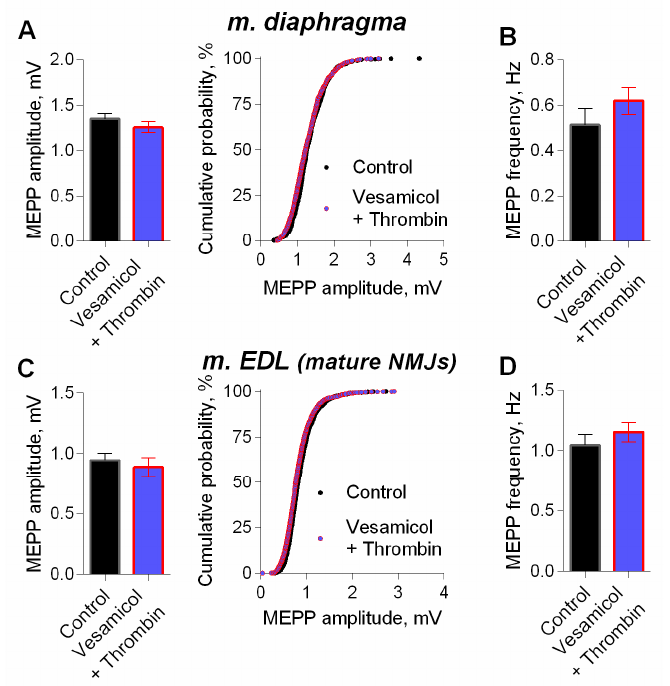
Figure 4. Inhibition of vesicular ACh transporter abolished thrombin-induced increase in MEPP amplitude. ( A ) Mean amplitude of MEPPs (left) and cumulative probability plots (right) in control ( n = 21) and upon application of thrombin (1 nM) in the presence of vesamicol (1 µ M) ( n = 24) at diaphragm NMJs. ( B ) Mean frequency of MEPPs in control and upon application of thrombin in the presence of vesamicol at diaphragm NMJs. ( C ) Mean amplitude of MEPPs (left) and cumulative probability plots (right) in control ( n = 25) and upon application of thrombin in the presence of vesamicol at mature NMJs of m. EDL ( n = 28). ( D ) Mean frequency of MEPPs in control and upon application of thrombin in the presence of vesamicol at m. EDL mature NMJs. Histograms and error bars represent the mean ± SEM.